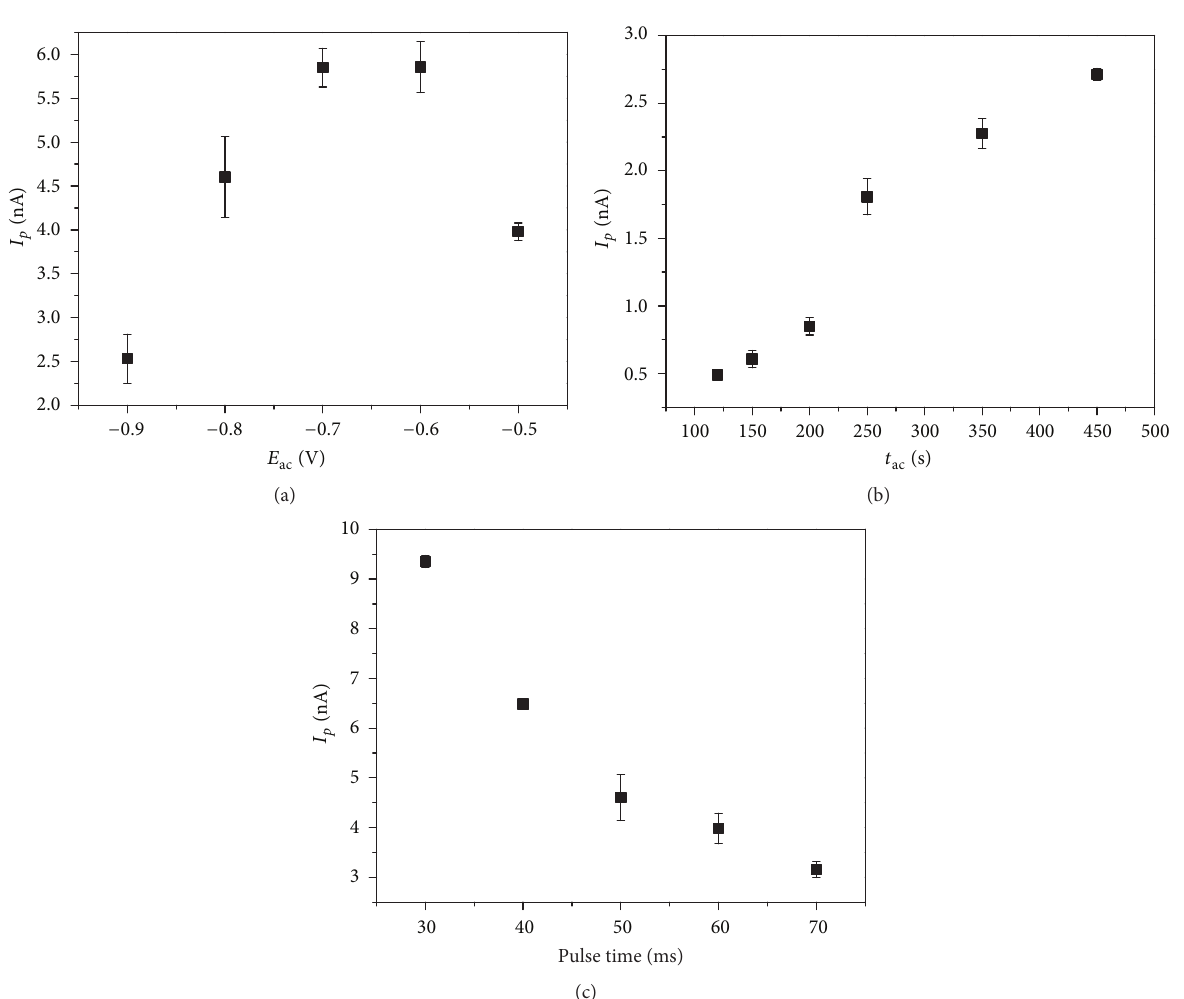
: 150s; pulse amplitude: 70 mV; and pulse time: 50 ms. (b) Effect of accumulation ac : − 0.7 V. (c) Effect of pulse time with ac : 150s; pulse amplitude: 50 mV; and 𝐸 : − 0.7V. ac ac